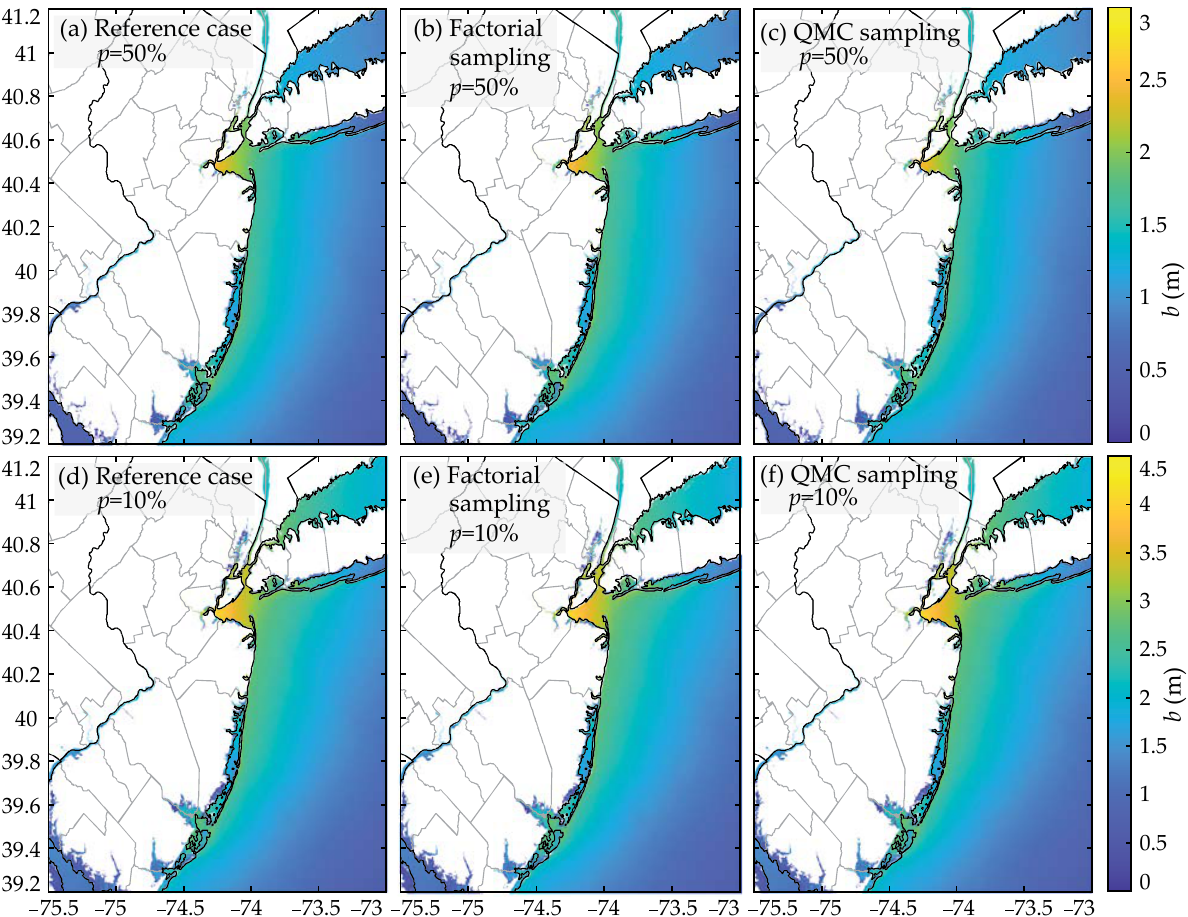
Figure 9. Distribution over the spatial domain of interest of the thresholds corresponding to exceedance probabilities 50% (top row) and 10% (bottom row) for advisory A 1 and scenario U 1 for super storm Sandy. Three different sampling approaches are presented for estimating the desired statistics: The reference case (left column) is presented to establish the comparisons between the factorial P-Surge sampling (middle column) and the QMC sampling (right column) for a N r value similar to the one used for the factorial P-surge sampling.